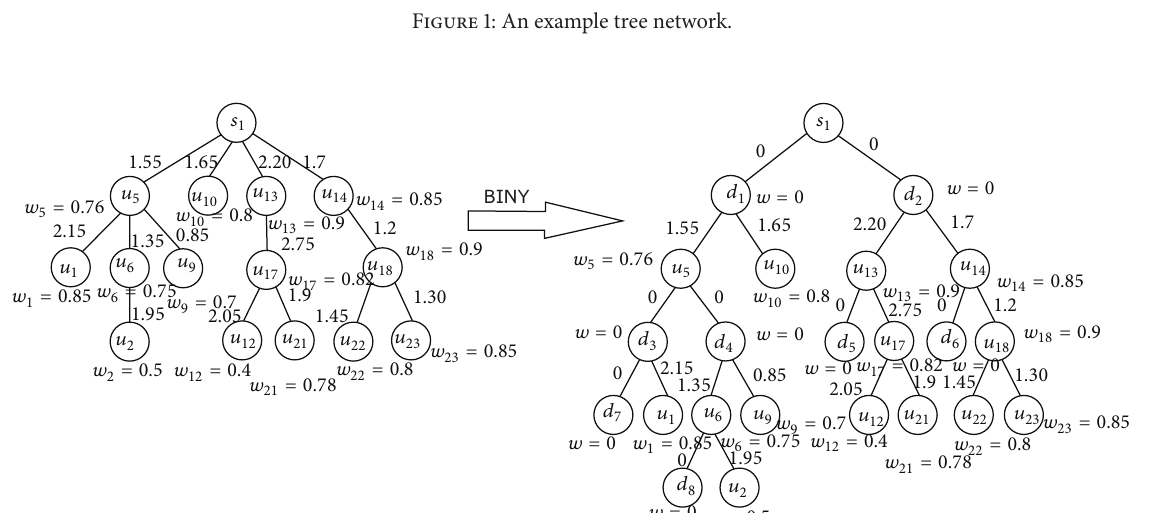
Figure 2: Illustration for 𝑇(𝑠 1 ) and 𝑏(𝑇(𝑠 1 ))